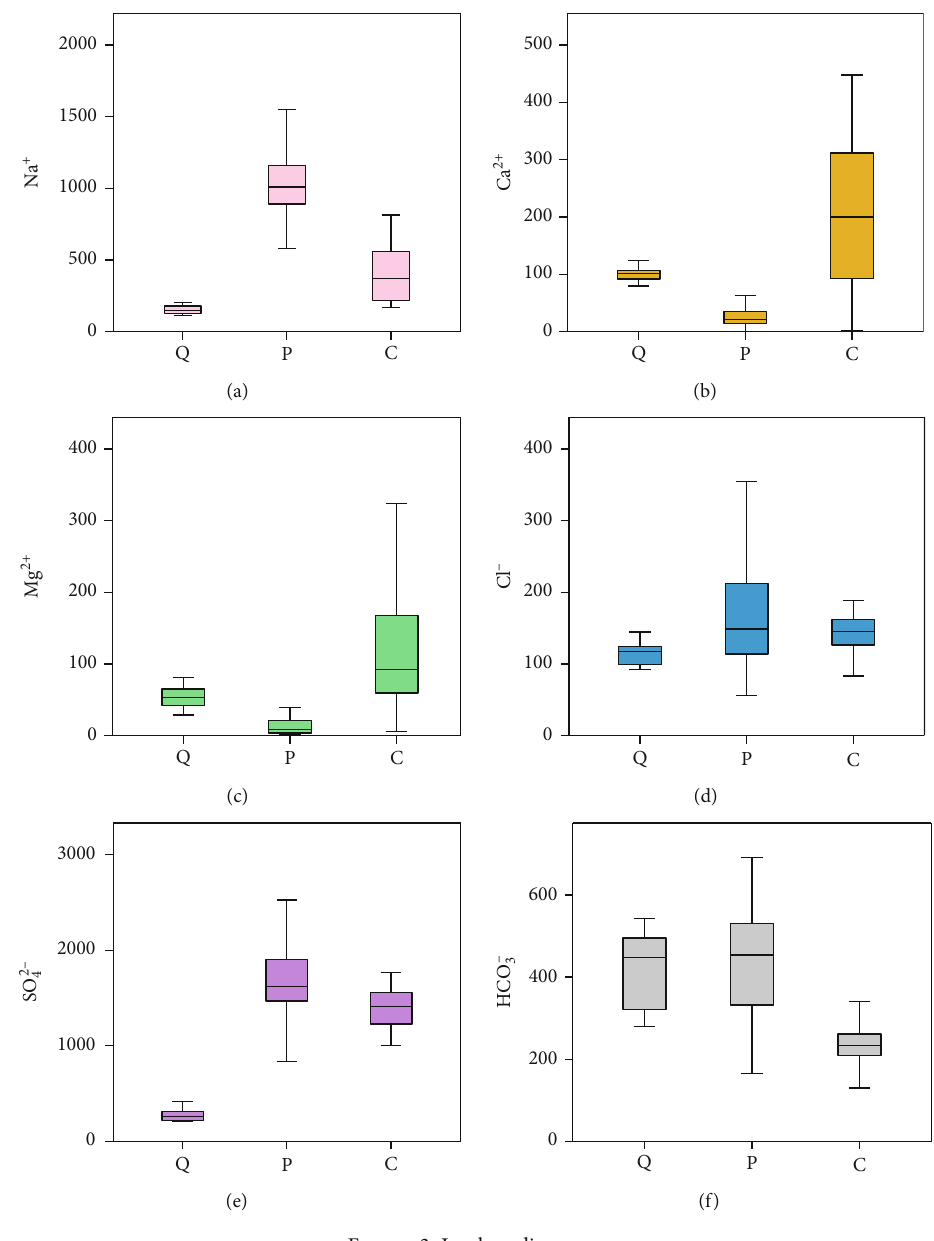
Figure 3: Ion box